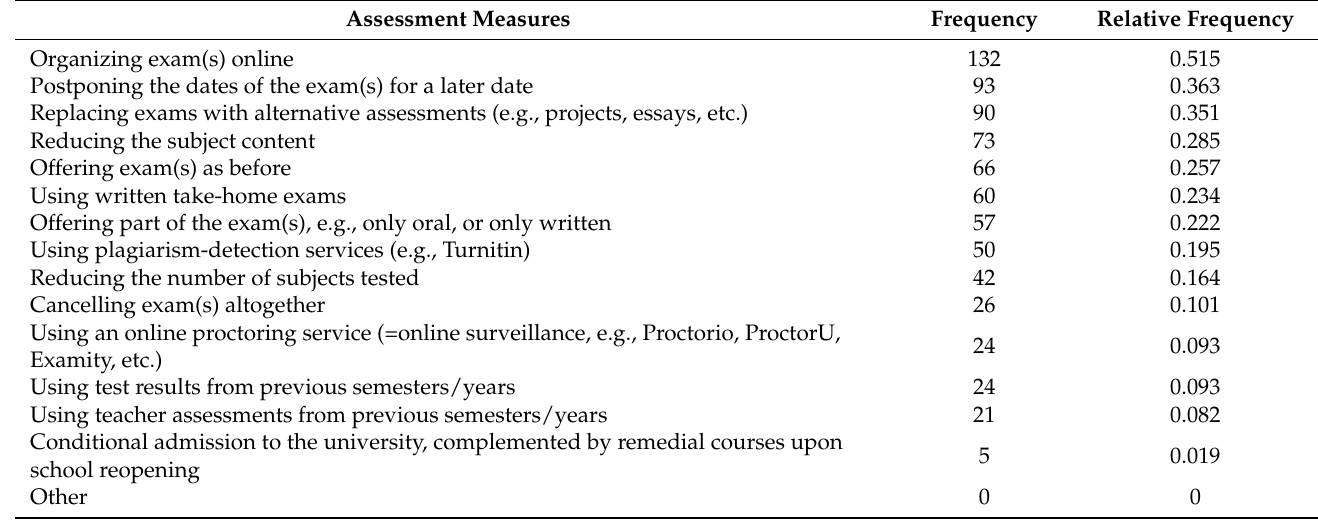
Table 2. Relative frequency of the responsive assessment measures during the